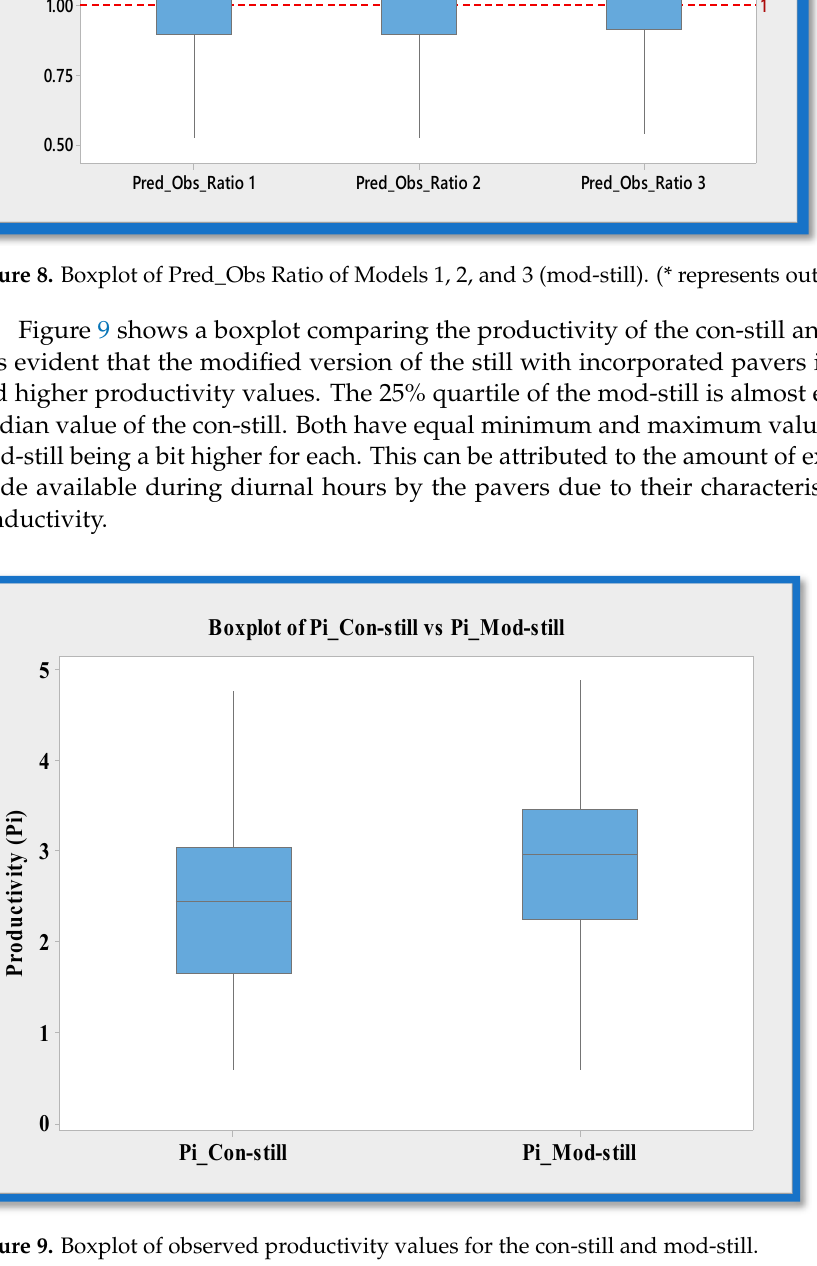
Figure 9. Boxplot of observed productivity values for the con-still and mod-still.